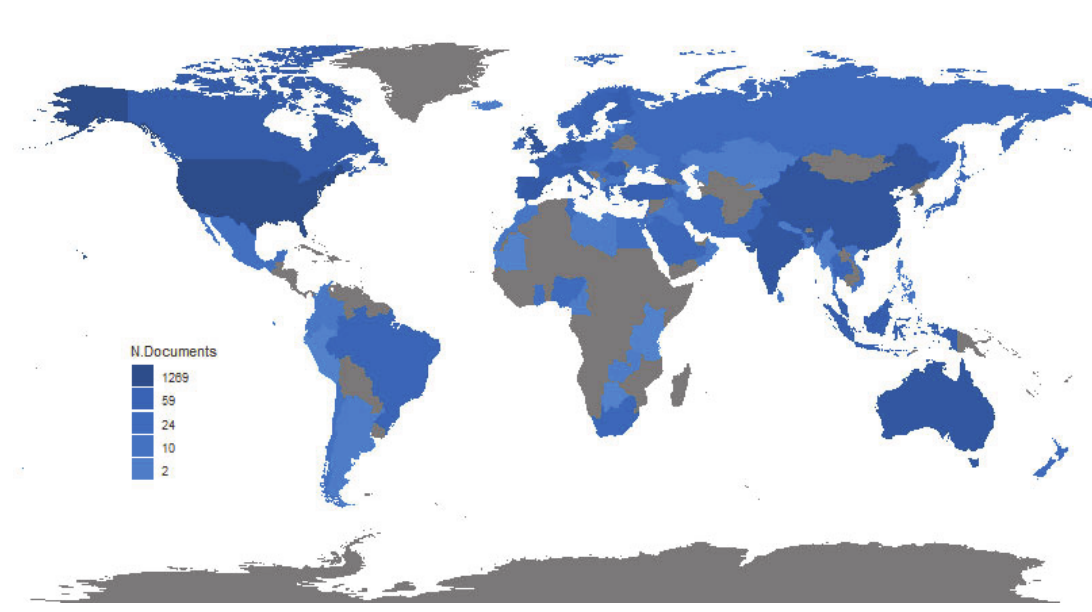
Fig. 3. Country scientific production on